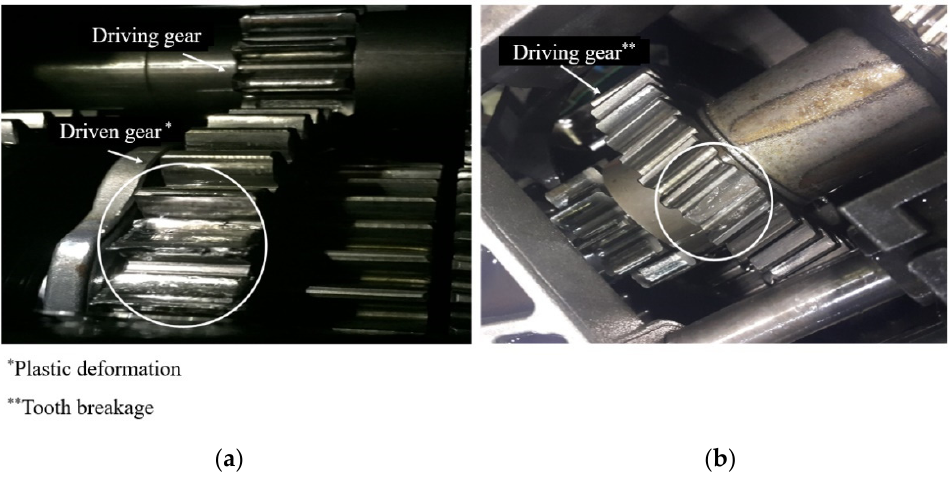
Figure 3. Results of gear failure type after field test: ( a ) range shift A gears; ( b ) range shift B gears.